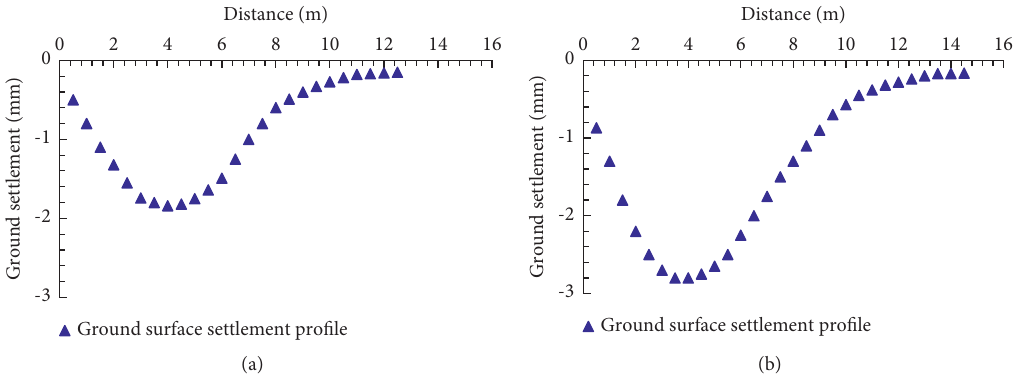
Figure 18: Influence of the optimum servo steel axial loading capacity application on ground surface influence zone settlement profile at the actual site. (a) ZQT21. (b)